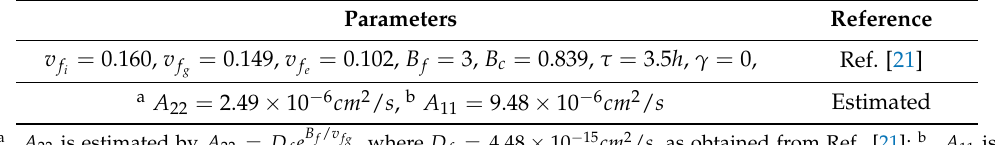
Table 1. Model parameters for bisphenol-A benzophenone-dicarboxylic acid (BPA-BnzDCA)